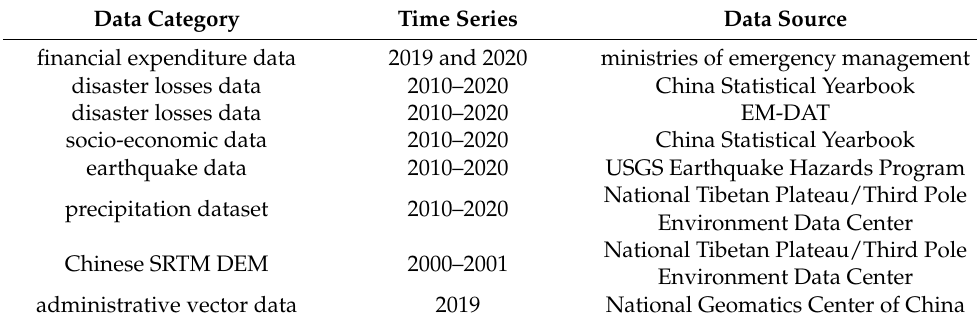
Table 1. The list of data used in this